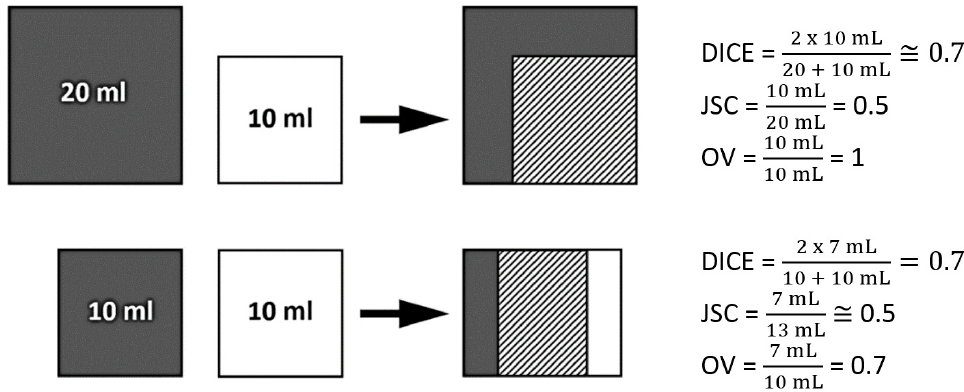
Figure 6. Simplified schematic representation of the different spatial similarity indices (DICE, JSC and OV) modified from Lohmann et al. [28].